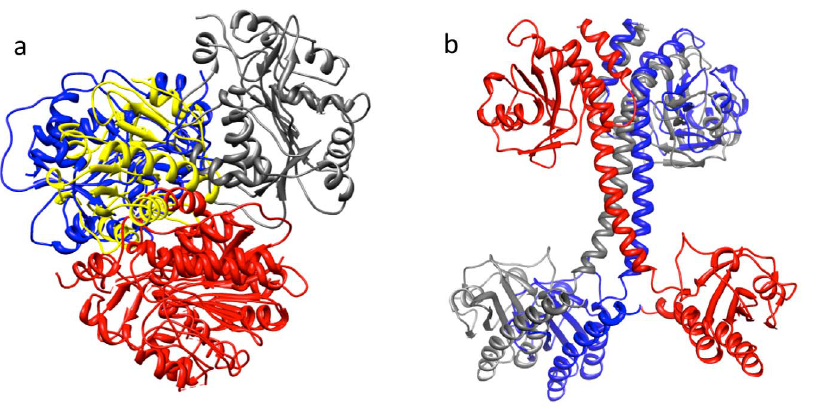
Figure 4. DockScore performance on the superfamilies known to possess different modes of dimerization. DockScore was tested for its ability to distinguish the different modes of dimerization in four of the superfamilies, namely GAF domains, IL-8 like superfamily, DJ1 superfmily and H-NS histone like proteins. For the superfamily DJ-1, out of the four different known dimerization modes, DockScore assigned top rank to native pose in two of the modes. One of the chains is shown in red, the native pose of the other chain in grey and the non-native pose in blue colour. (a) In one of the modes (1IZY), we observed that the non-native pose, obtaining the highest score, was structurally very similar to the native pose observed in another dimerization mode of the same superfamily (1VHQ). (b) In GAF domains, 1MC0, the top-ranked pose was very similar to the native pose. In yellow is another type of dimerization mode observed in DJ-1 superfamily.